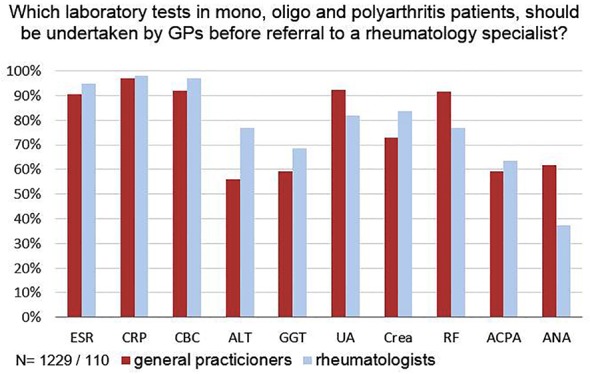
Opinion on laboratory examinations to be performed by the GP prior to referral to the rheumatologist in case of arthritis.Abbreviations: ESR, erythrocyte sedimentation rate; CRP, C-reactive protein; CBC, complete blood count; ALT, alanine transaminase; GGT, gamma-glutamyl transferase; UA, uric acid; Crea, creatinine; RF, rheumatoid factor; ACPA, antibodies against citrullinated protein/peptide antigens; ANA, anti-nuclear-antibodies. The differences between GPs and rheumatologists were statistically significant for ALT (p<0.001), Uric acid (p = 0.001), Creatinine (p = 0.035), RF (p<0.001), ANA (p<0.001). * p value based on Fisher's exact test.